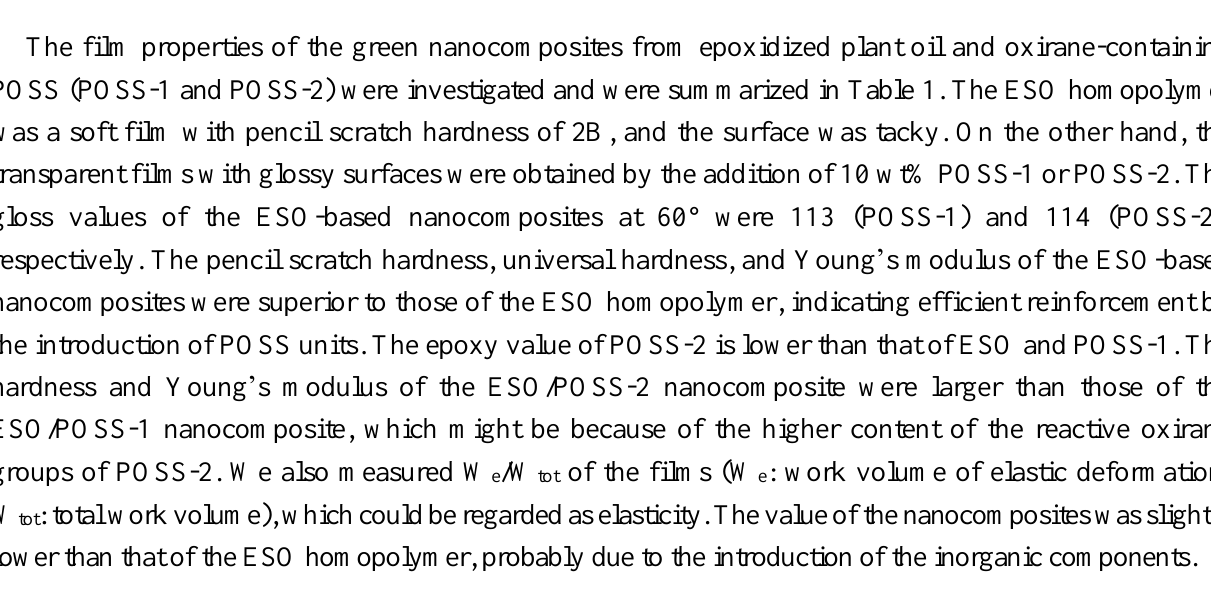
Table 1. Film properties of green nanocomposites.